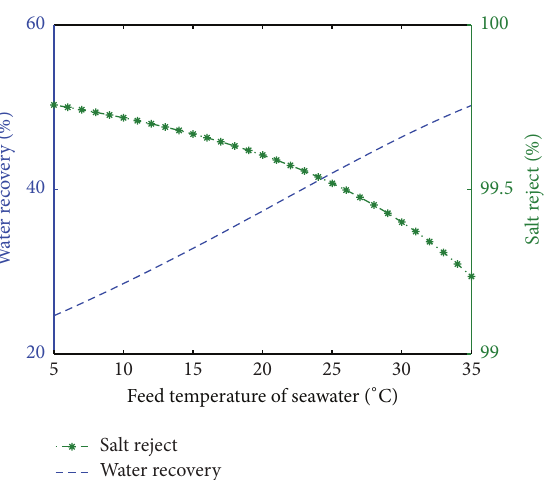
Figure 13: Rec and Ry as the function of feed flow rate.